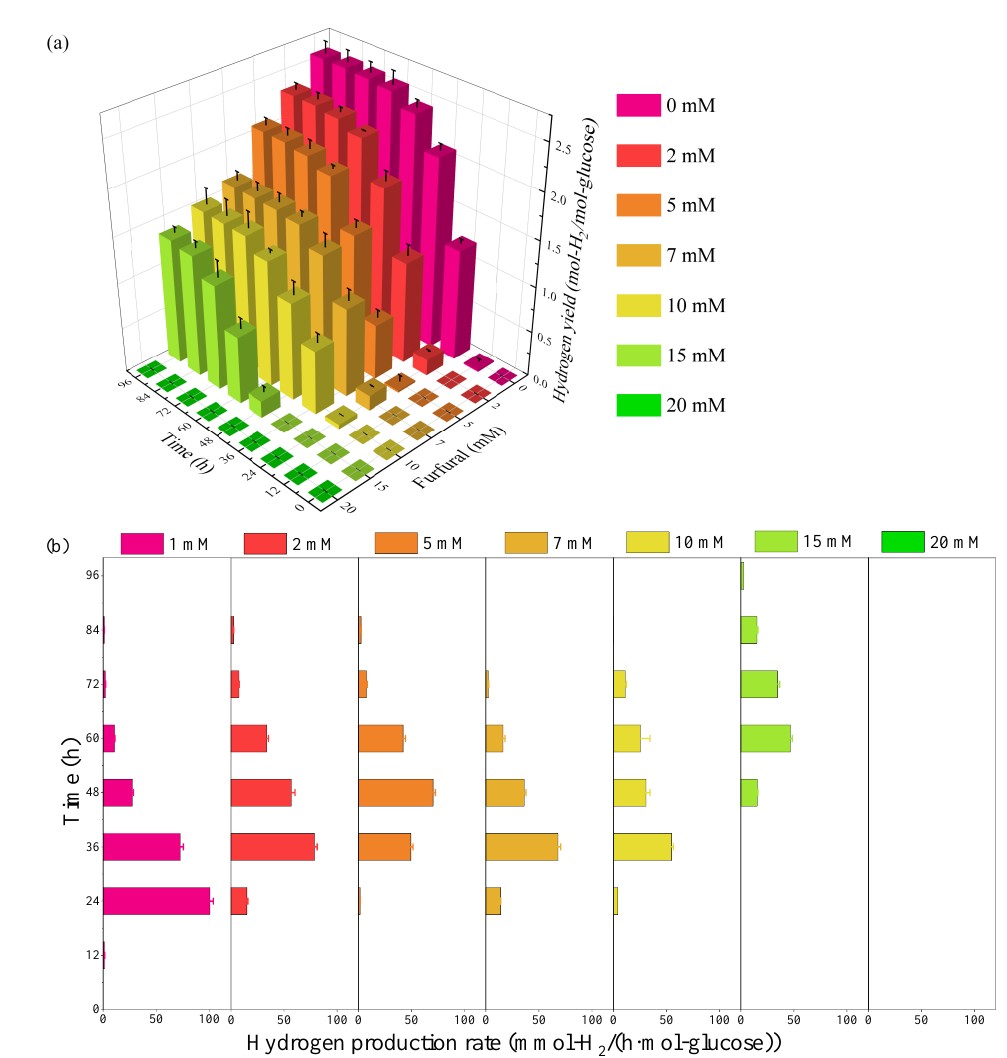
Figure 1. Hydrogen production from glucose in the presence of furfural: ( a ) accumulative hydrogen yield, and ( b ) hydrogen production rate. Table 1. Effects of various furfural concentrations (0–20 mM) on hydrogen production potential, maximum hydrogen production rate, lag